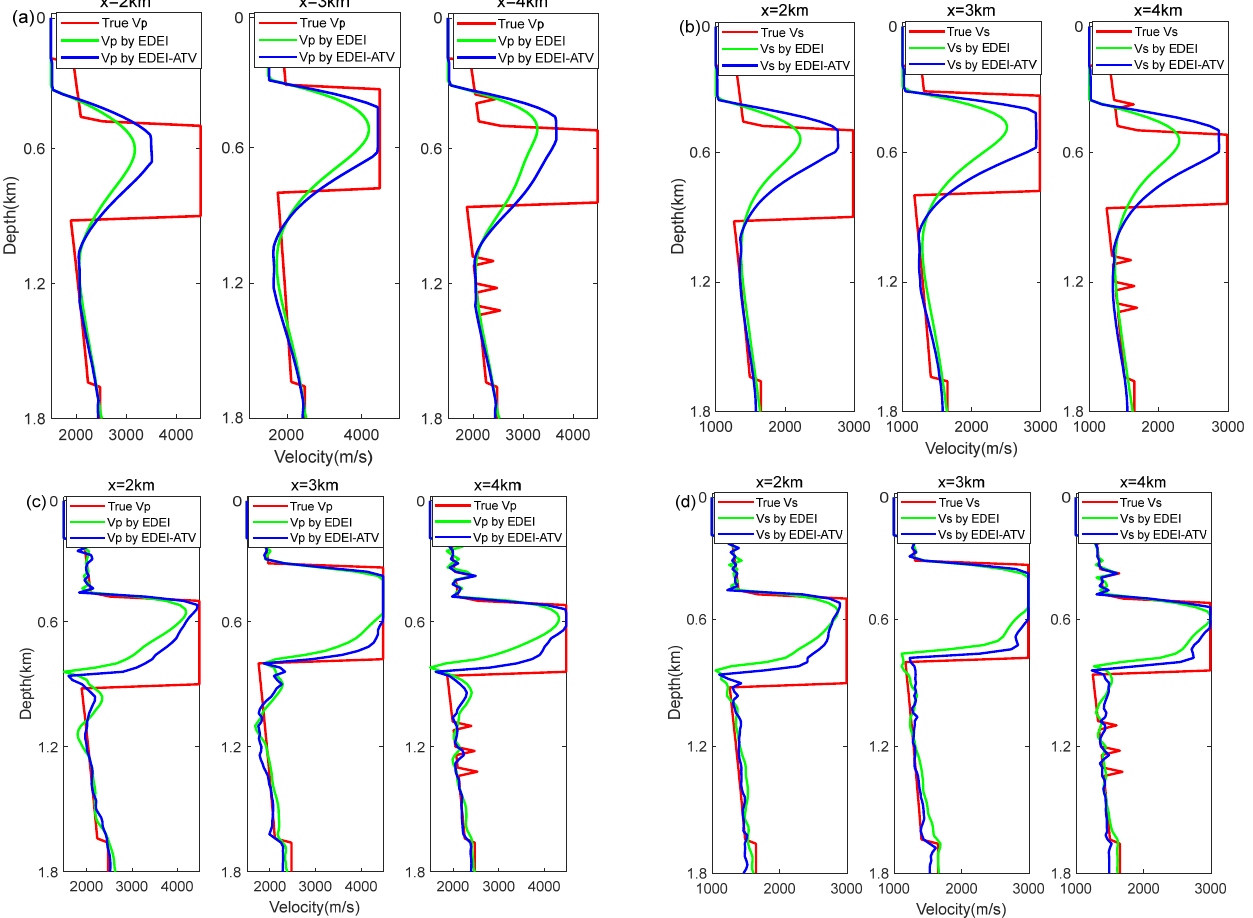
Figure 7. Extracted traces comparison of inversion results. ( a ) Extracted traces comparison of inverted Vp by EDEI and EDEI-ATV; ( b ) Extracted traces comparison of inverted Vs by EDEI and EDEI-ATV; ( c ) Extracted traces comparison of inverted Vp by EDEI+EFWI and EDEI-ATV+EFWI-ATV; ( d ) Extracted traces comparison of inverted Vs by EDEI+EFWI and EDEI-ATV+EFWI-ATV.